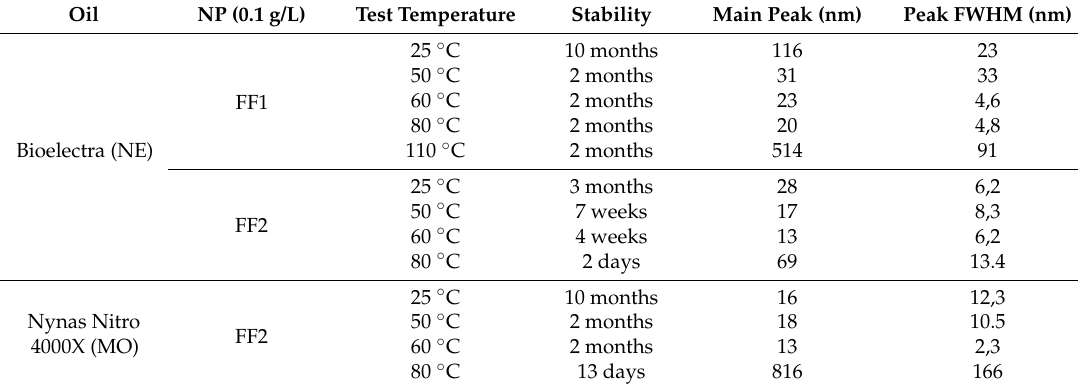
Table 4. Stability tests according to particle size measurements. FWHM is the full peak width at half